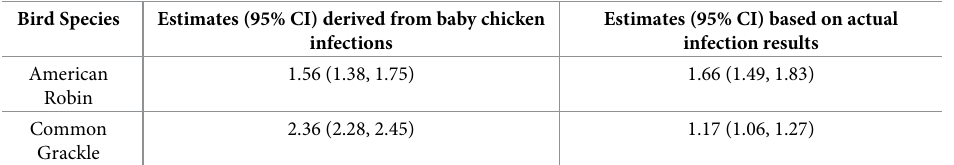
Table 3. Comparative index values (95% confidence intervals) of host competence for West Nile virus-infectious- ness to Culex pipiens mosquitoes by viremic robins and grackles, as estimated mathematically from a dose- response equation generated from mosquito feedings on viremic baby chickens versus measuring actual mosquito infections that resulted from feedings on viremic robins and grackles. Bird